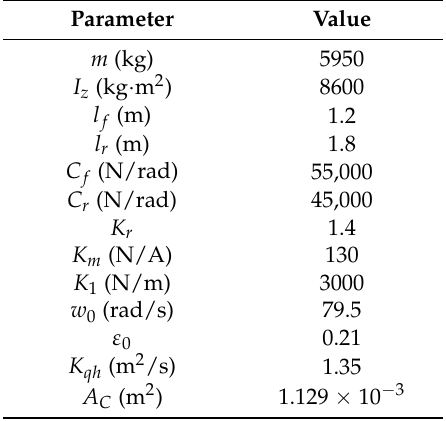
Table 1. The parameters of the 4WS vehicle.